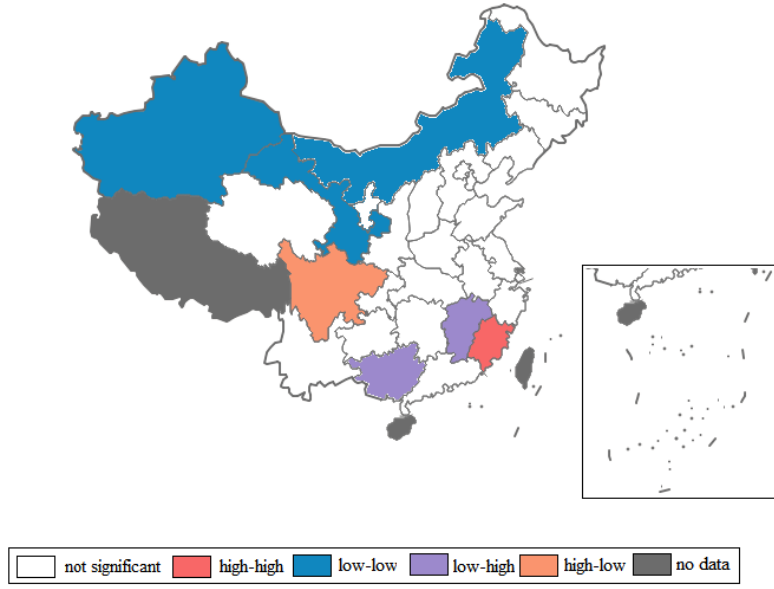
Figure 2. Spatial aggregation of urban residents’ electricity consumption in 2016.